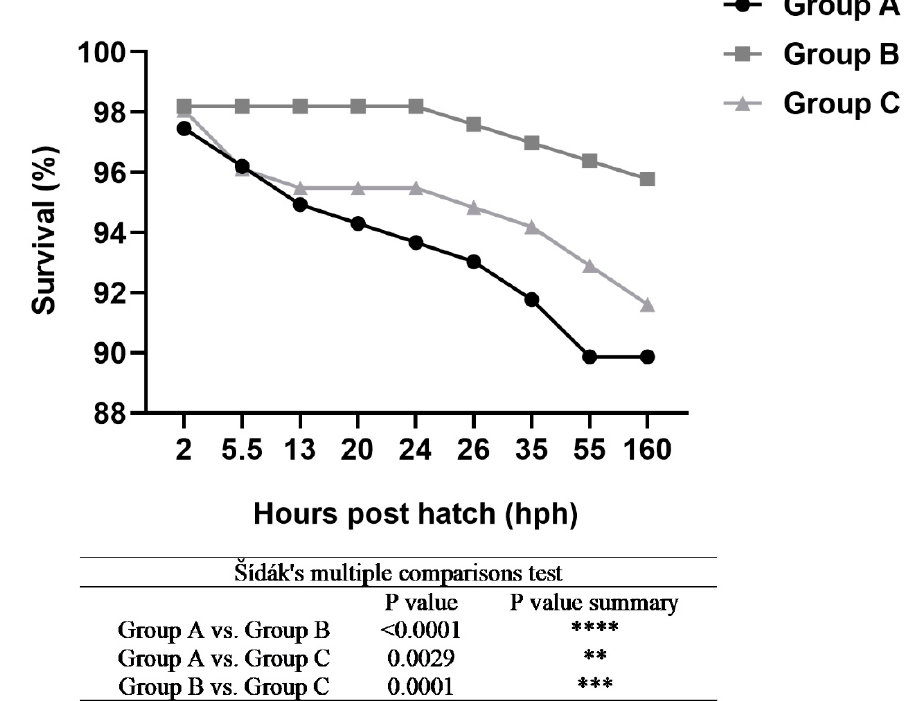
Figure 5. Survival rate of hybrid sturgeons in experimental groups.